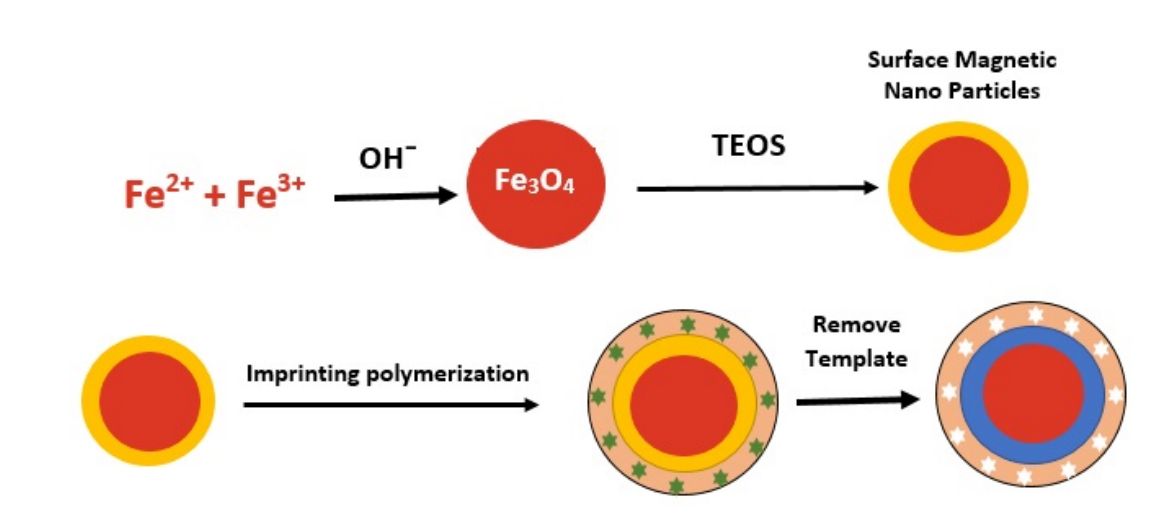
Figure 4. The preparation of MMIPs using silica.